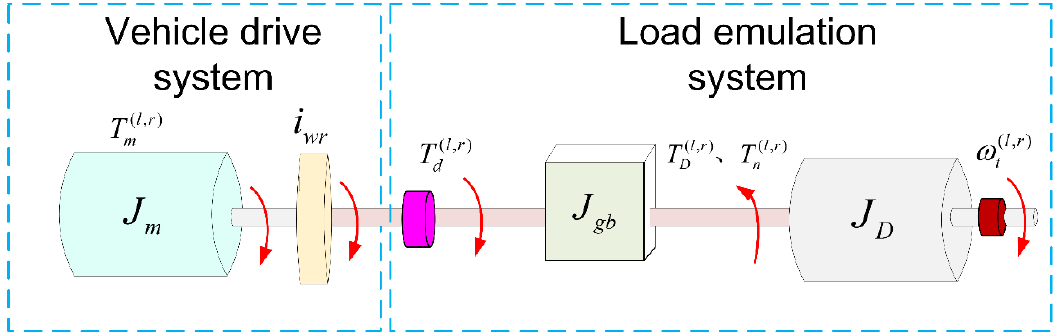
Figure 7. Dynamics of a single side test bench.